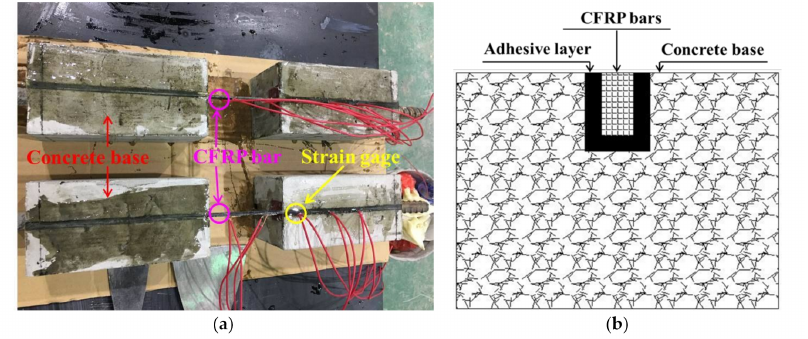
Figure 3. The Optimization coefficient of adhesive layer thickness: ( a ) Specimens; ( b ) Schematic diagram of cross-section by NSM.